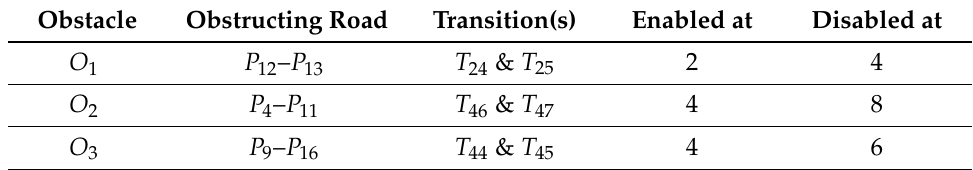
Table 3. Emulated dynamic